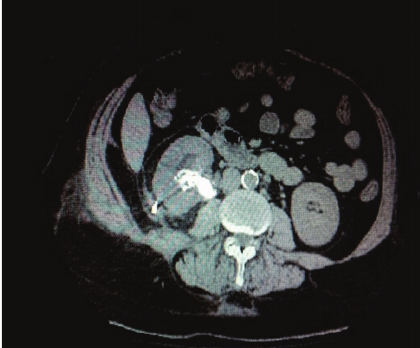
Figure 3: CT scan of the abdomen and pelvis showing a right staghorn calculus, right hydronephrosis with air in the collecting system, and perinephric